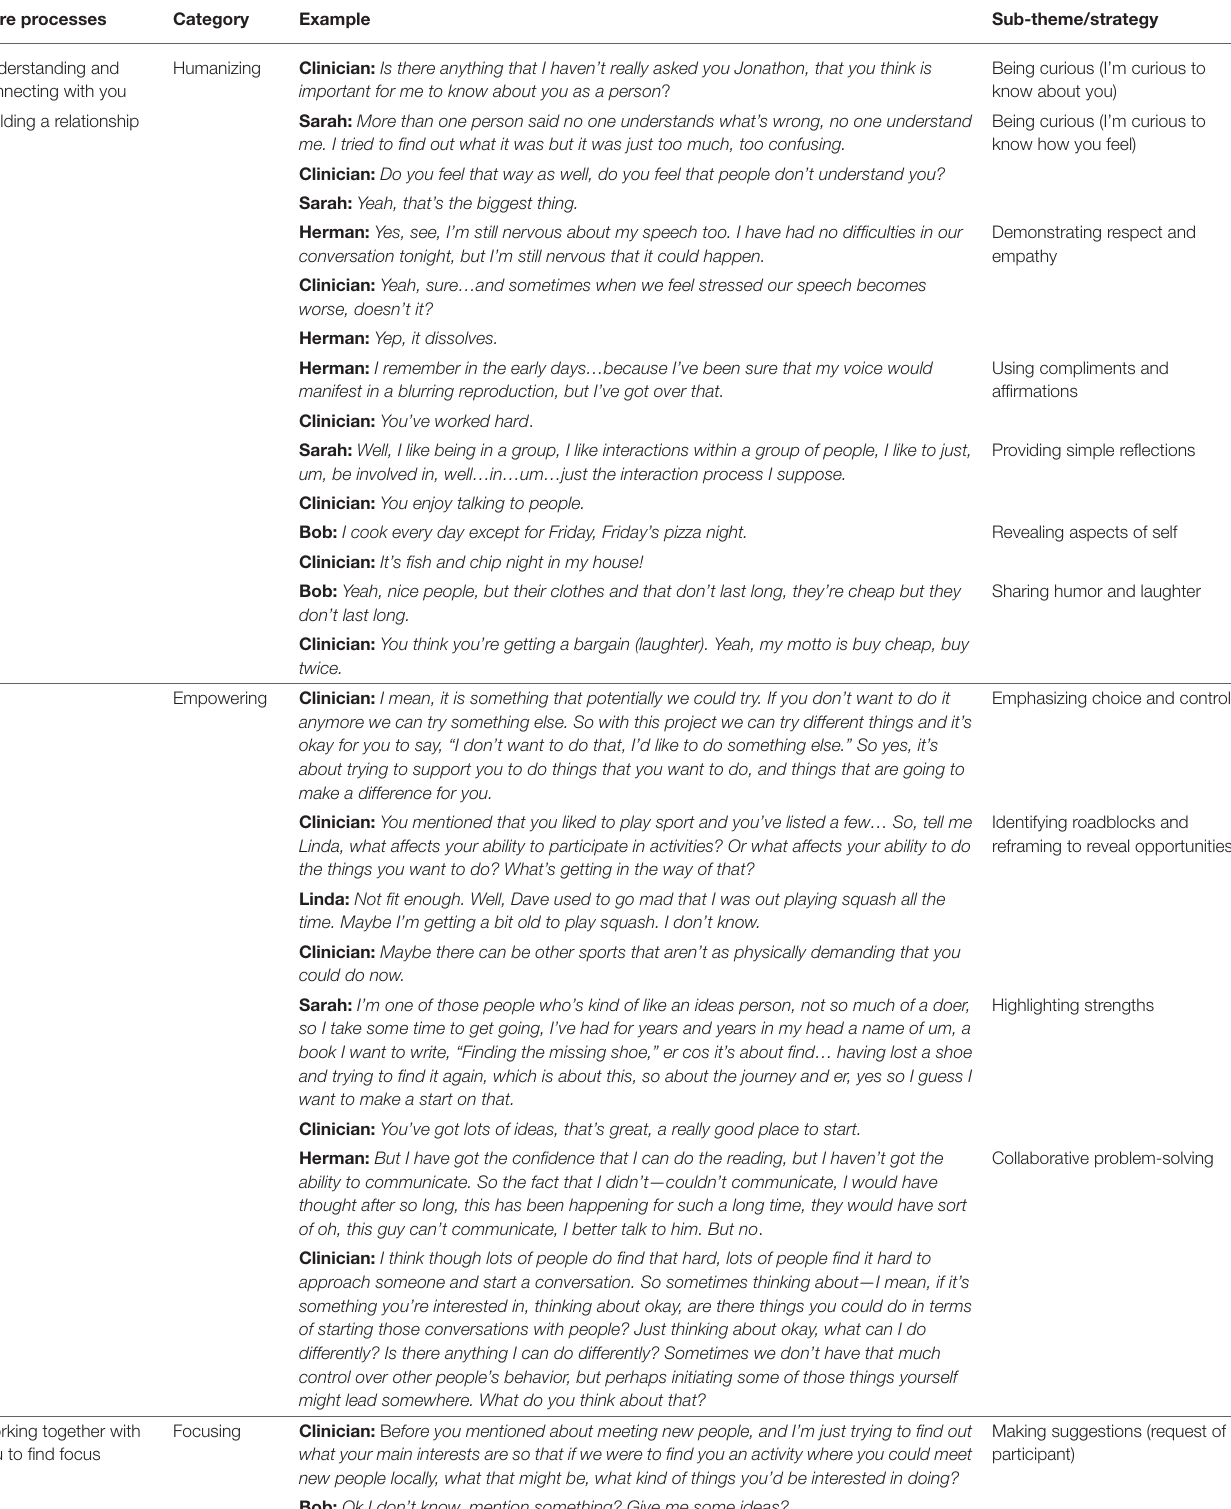
TABLE 2 | Results of thematic